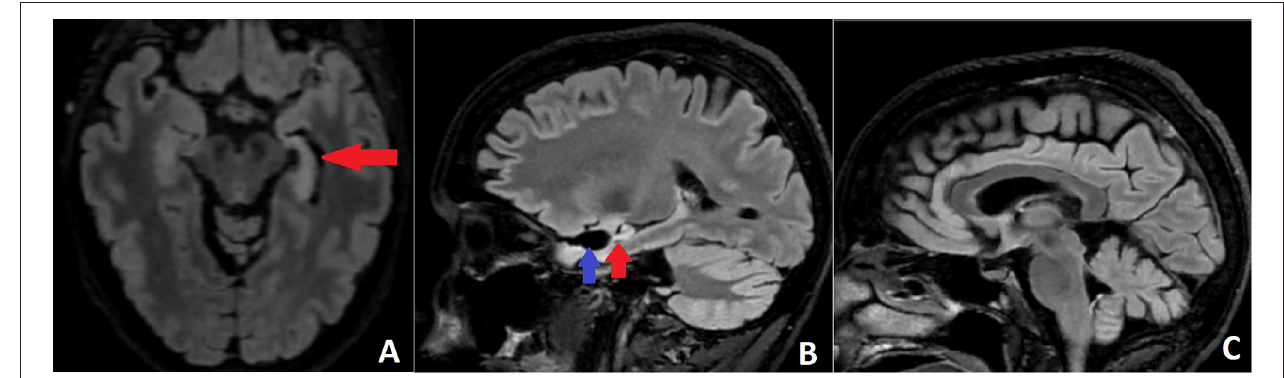
FIGURE 3 | (A) Axial FLAIR MRI with left HS (red arrow). (B) Sagittal FLAIR MRI scan demonstrating the postoperative defect (blue arrow) and the left HS (red arrow). (C) Sagittal FLAIR MRI without obvious signs of cerebellar and brainstem